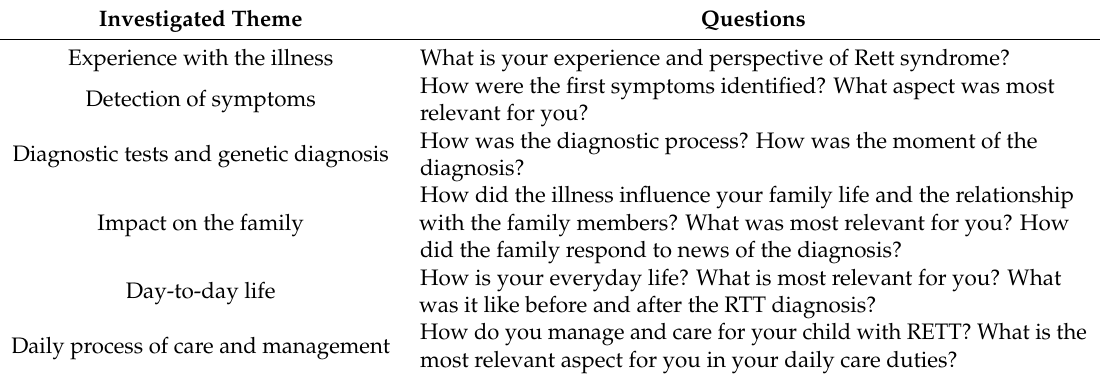
Table 2. Questions